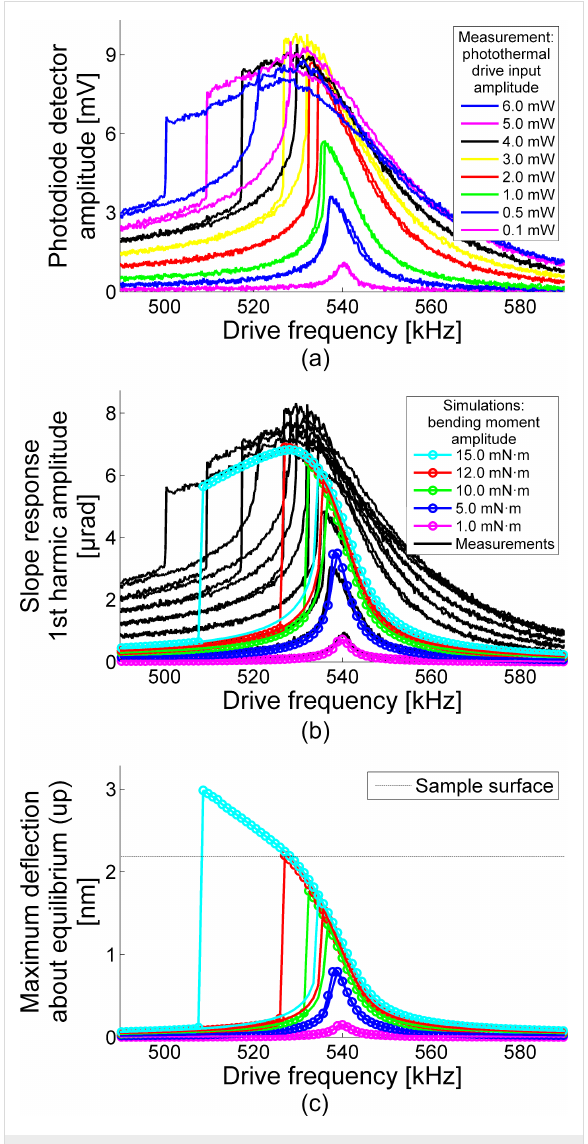
Figure 1: (a) AFM frequency sweep measurements depicted by photo- diode detector amplitudes versus photothermal excitation frequency. Colored curves (sweep up and down) identify various photothermal ex- citation input amplitudes. (b,c) Dynamic simulations of cantilever driven about contact resonance frequency using ten free cantilever eigenfunc- tions as a basis set. Measurement data is converted to slope response and depicted as black curves. Simulation data points are shown as colored circles, closed for increasing frequency sweep and open for decreasing, with lines connecting to elucidate jumps between periodic solution branches for both slope response first harmonic amplitudes (b) and maximum probe deflection about equilibrium (c). The unde- formed sample surface location is indicated as a threshold for tip–sam- ple